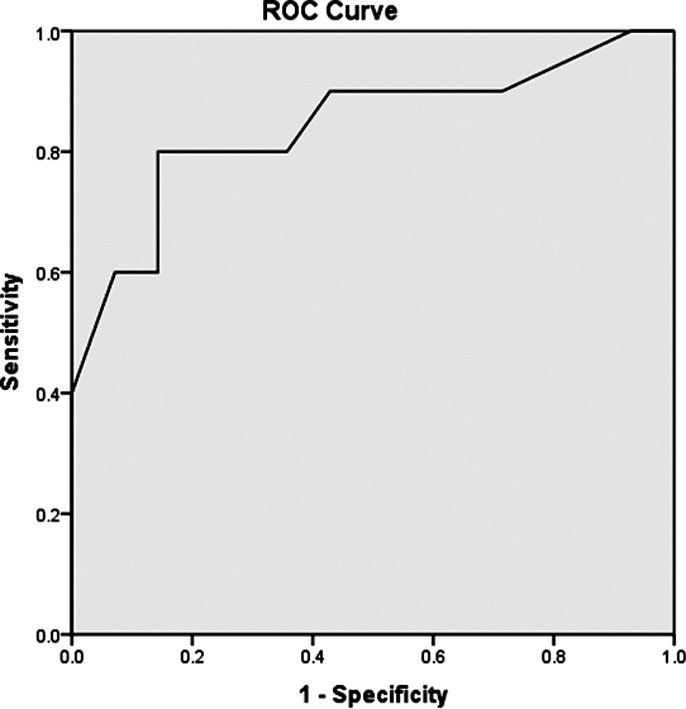
Correlation of high baseline serum creatinine with failure to improve HRS.Area under curve: 0.853